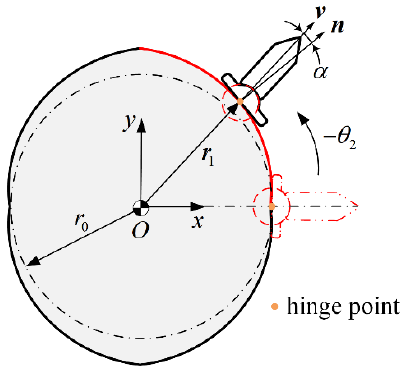
Figure 7. Wave generator profile model.